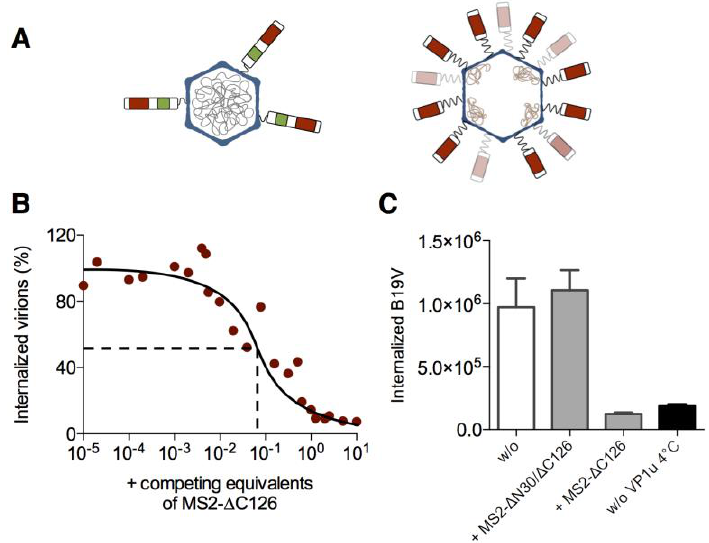
Figure 2. Competition of native B19V internalization with the MS2-VP1u bioconjugate. ( A ) Schematic comparison of the native B19V (three VP1u) with the MS2-∆C126 VP1u